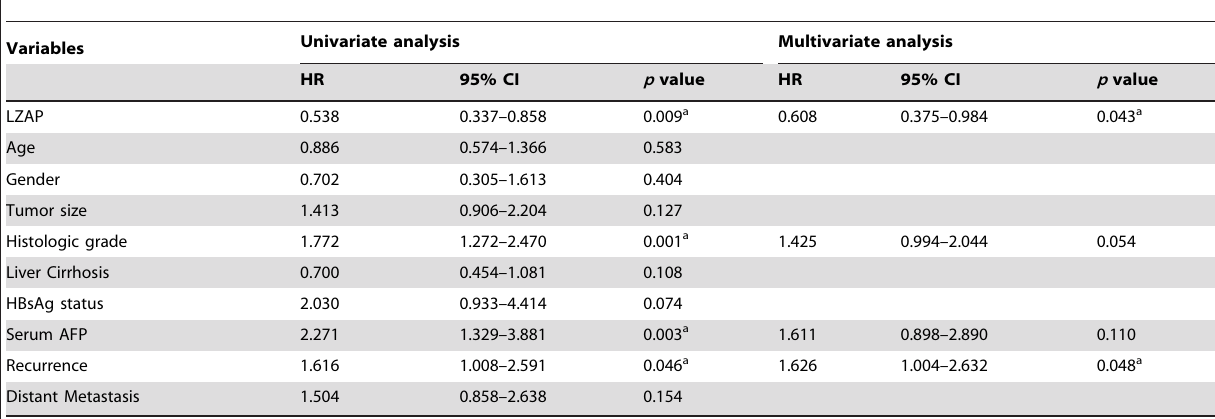
Table 2. Univariate and multivariate analysis of overall survival in hepatocellular carcinoma.